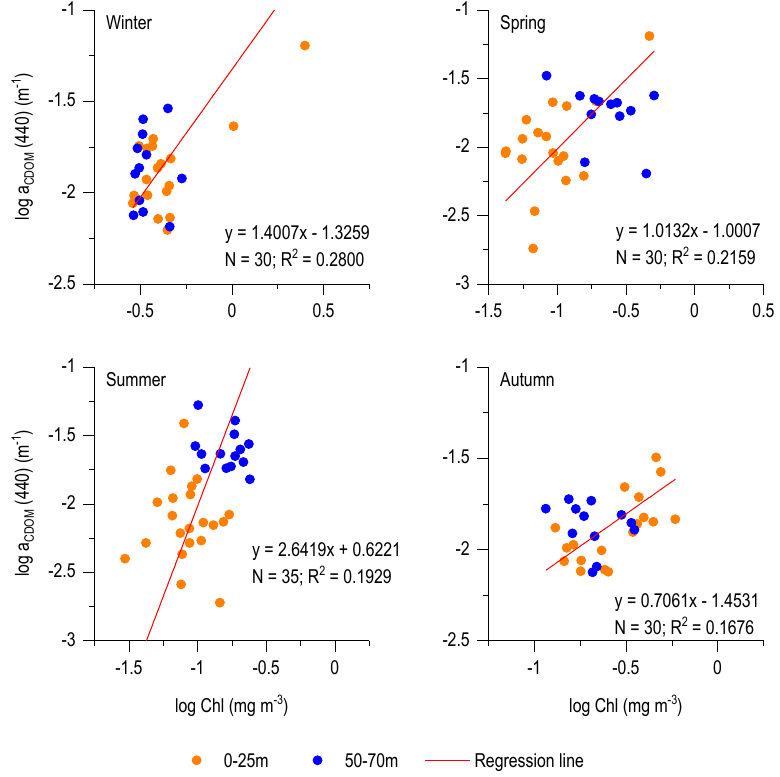
Figure 7. The same relation of the Figure 6 split in the four seasons. Orange points: surface samples (0.5–12.5); blue points: deep samples (50–70 m). (0.5–12.5); blue points: deep samples (50–70